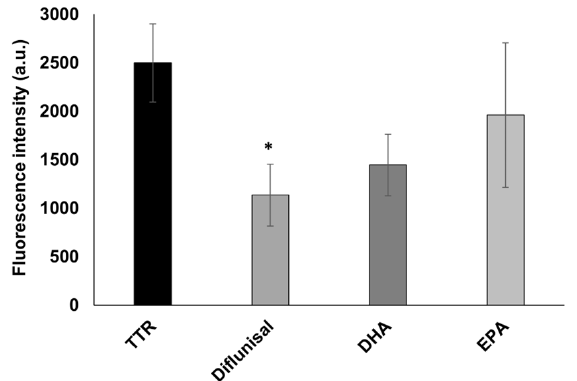
Figure 4. In vitro ThT fluorescence assay of wt-TTR in the absence or in the presence of diflunisal, DHA, and EPA. Values represent the fluorescence intensity mean ± SEM. The significance compared to TTR alone is assessed by one-way ANOVA test and Turkey post hoc test: * indicates significant difference vs. TTR (* p < 0.05).